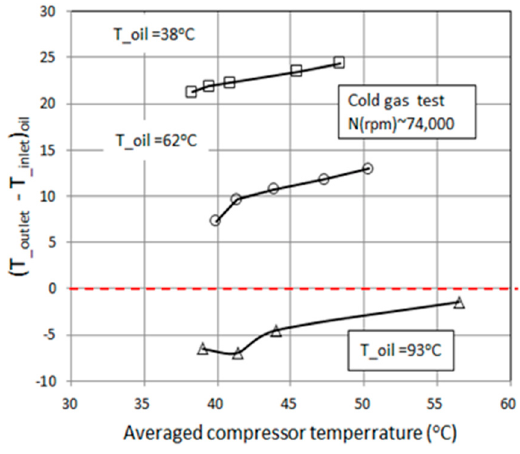
Figure 4. Oil temperature drop, according to oil inlet temperature condition.